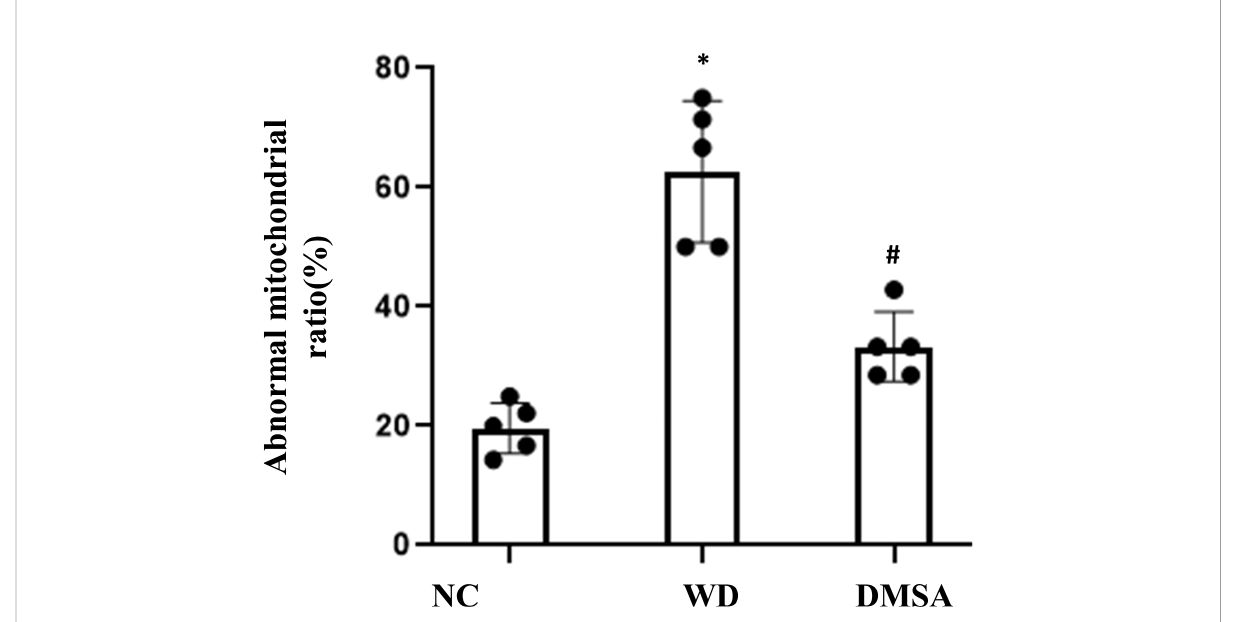
FIGURE 3 Ratio of abnormal mitochondria in hypothalamic neurons. Data are presented as mean ± SD.(*P<0.05, NC group vs. WD group; # P<0.05, WD group vs. DMSA group).